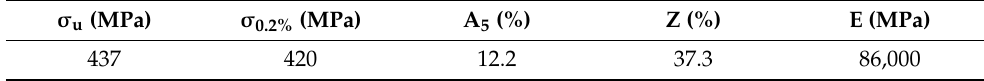
Table 2. Tensile test characteristics of AlMgSi1 alloys.